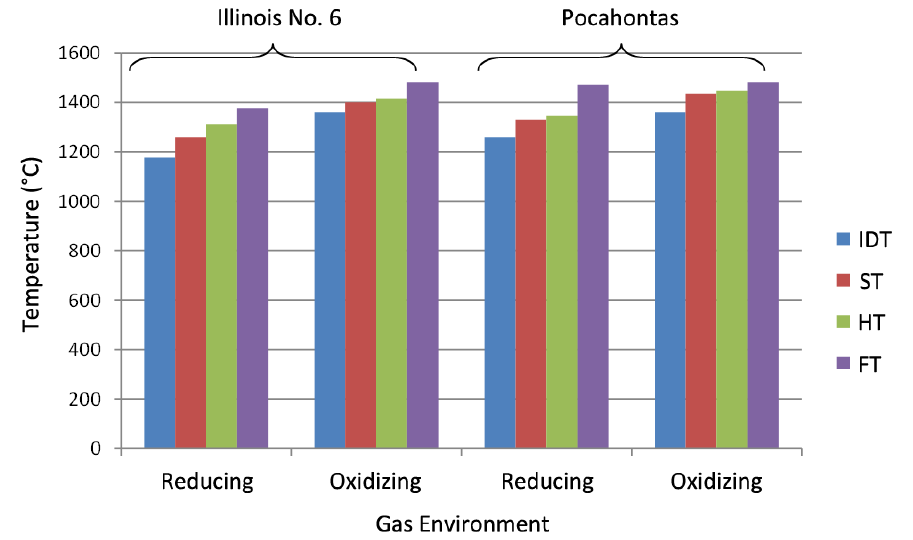
Figure 4. Ash fusion temperature under reducing and oxidizing conditions of selected coals